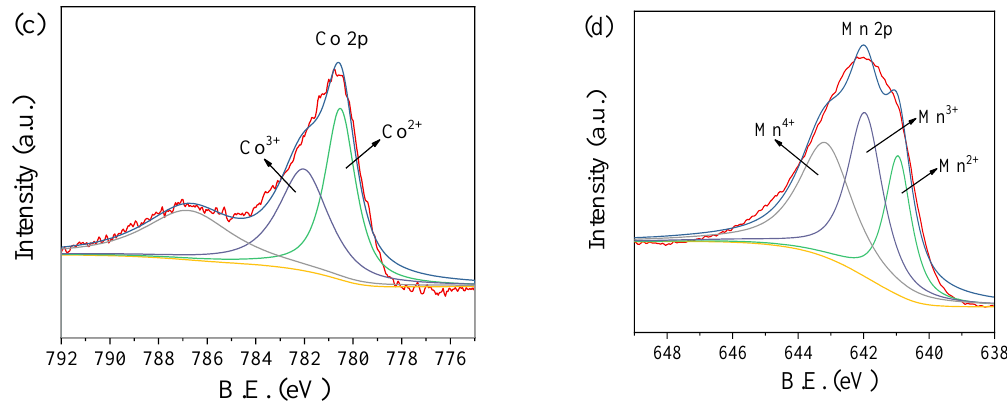
Figure 3. N 2 adsorption – desorption isotherms ( a ) and pore size distributions ( b ); Co 2p ( c ) and Mn 2p ( d ) spectrum of CoMn 2 O 4 .